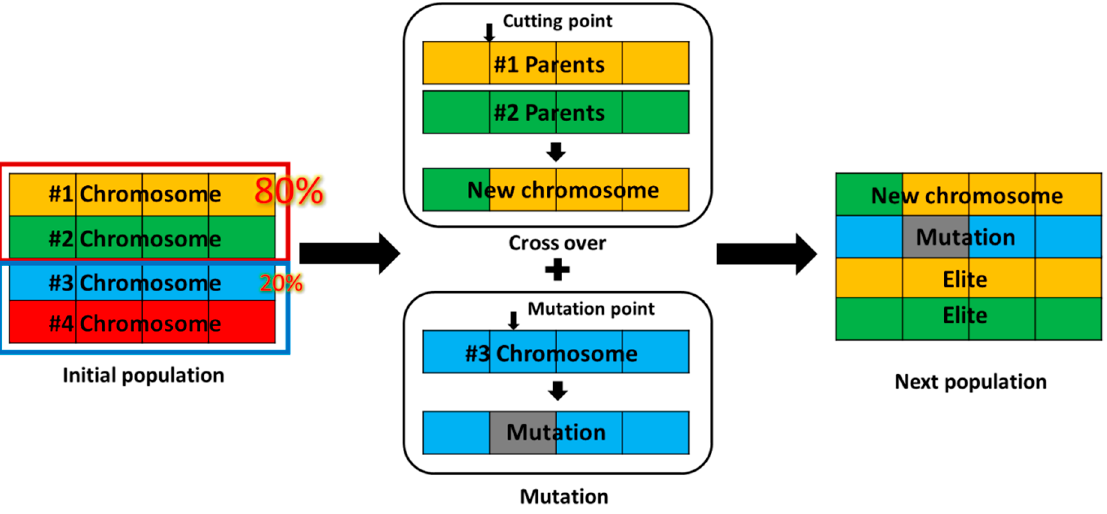
Figure 8. Examples of the reproduction operators used in the